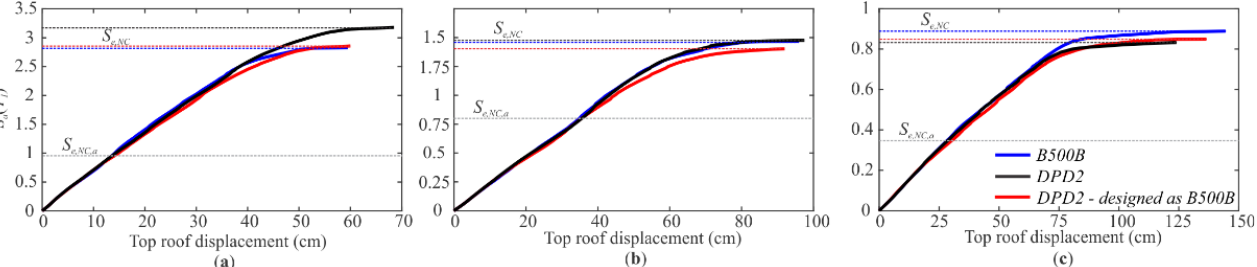
Figure 12. Target conditional acceleration spectra (median, 16th and 84th percentile), corresponding spectra of selected ground motions for an earthquake scenario based on S e,2475 , and acceleration spectra of each ground motion used for assessment of ( a ) 4-, ( b ) 8- and ( c ) 11-storey buildings.